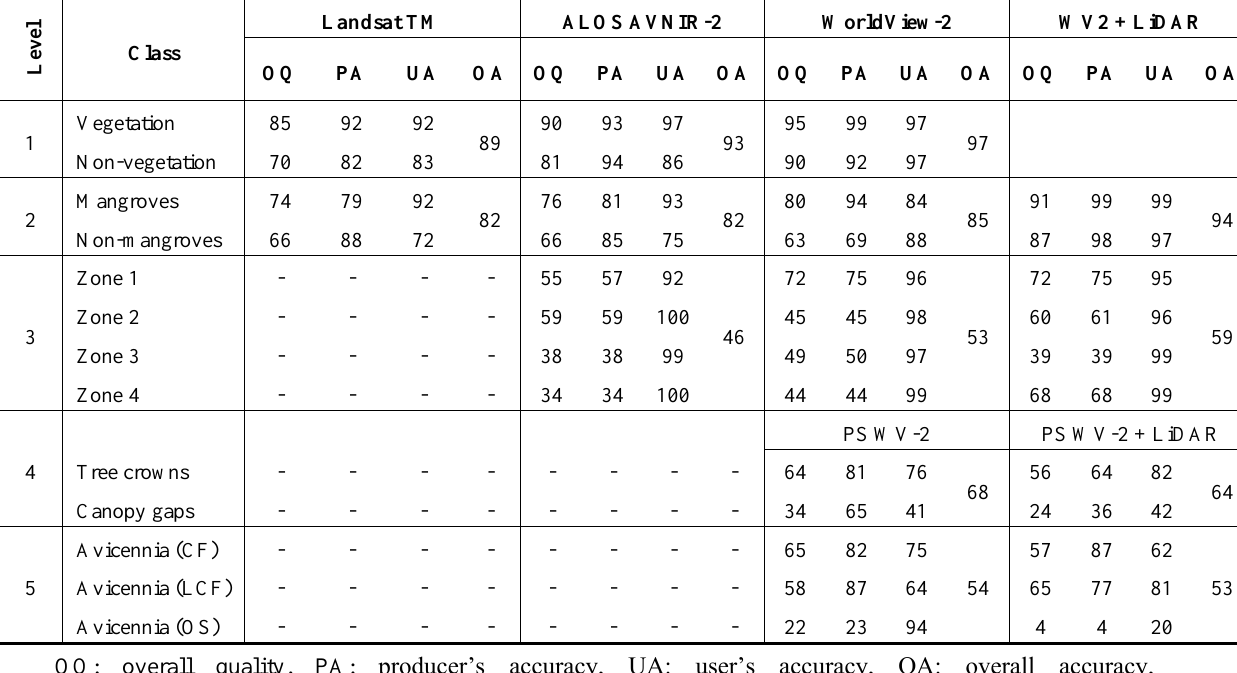
Table 5. Summary of the area-based accuracy descriptive statistics in percentage